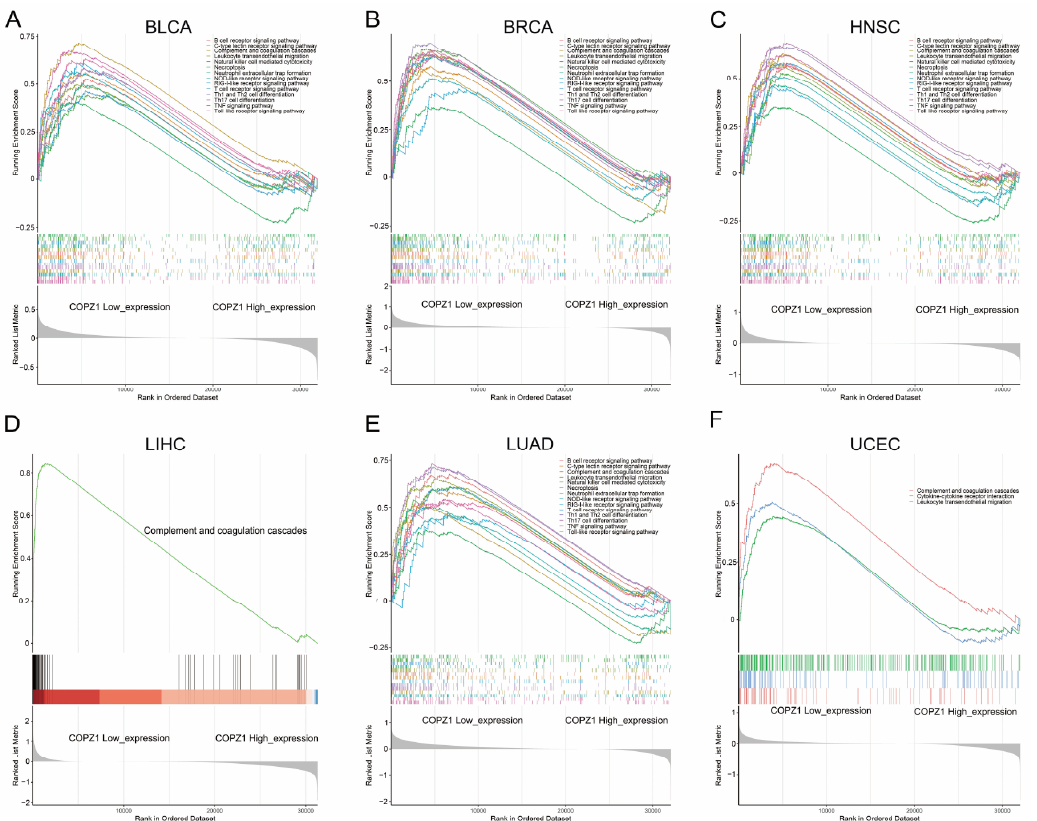
Figure 6. KEGG pathway GSEA analysis of COPZ1 low expression in multiple types of